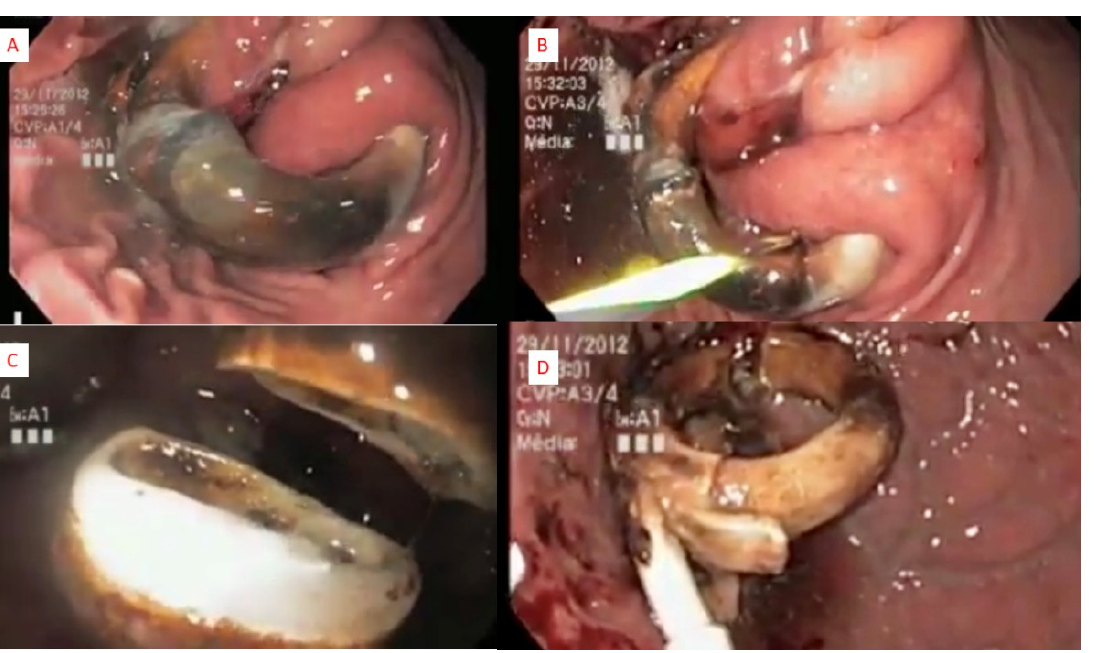
Figure 2. Operative technique: ( A )—initial aspect; ( B )—passage of the guidewire; ( C )—complete sectioning; ( D )—final aspect.